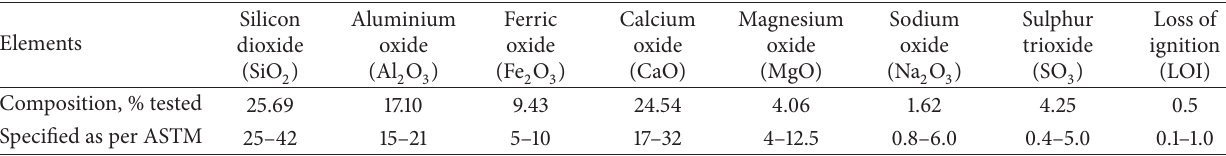
Table 1: Chemical Composition of Class C fly ash.